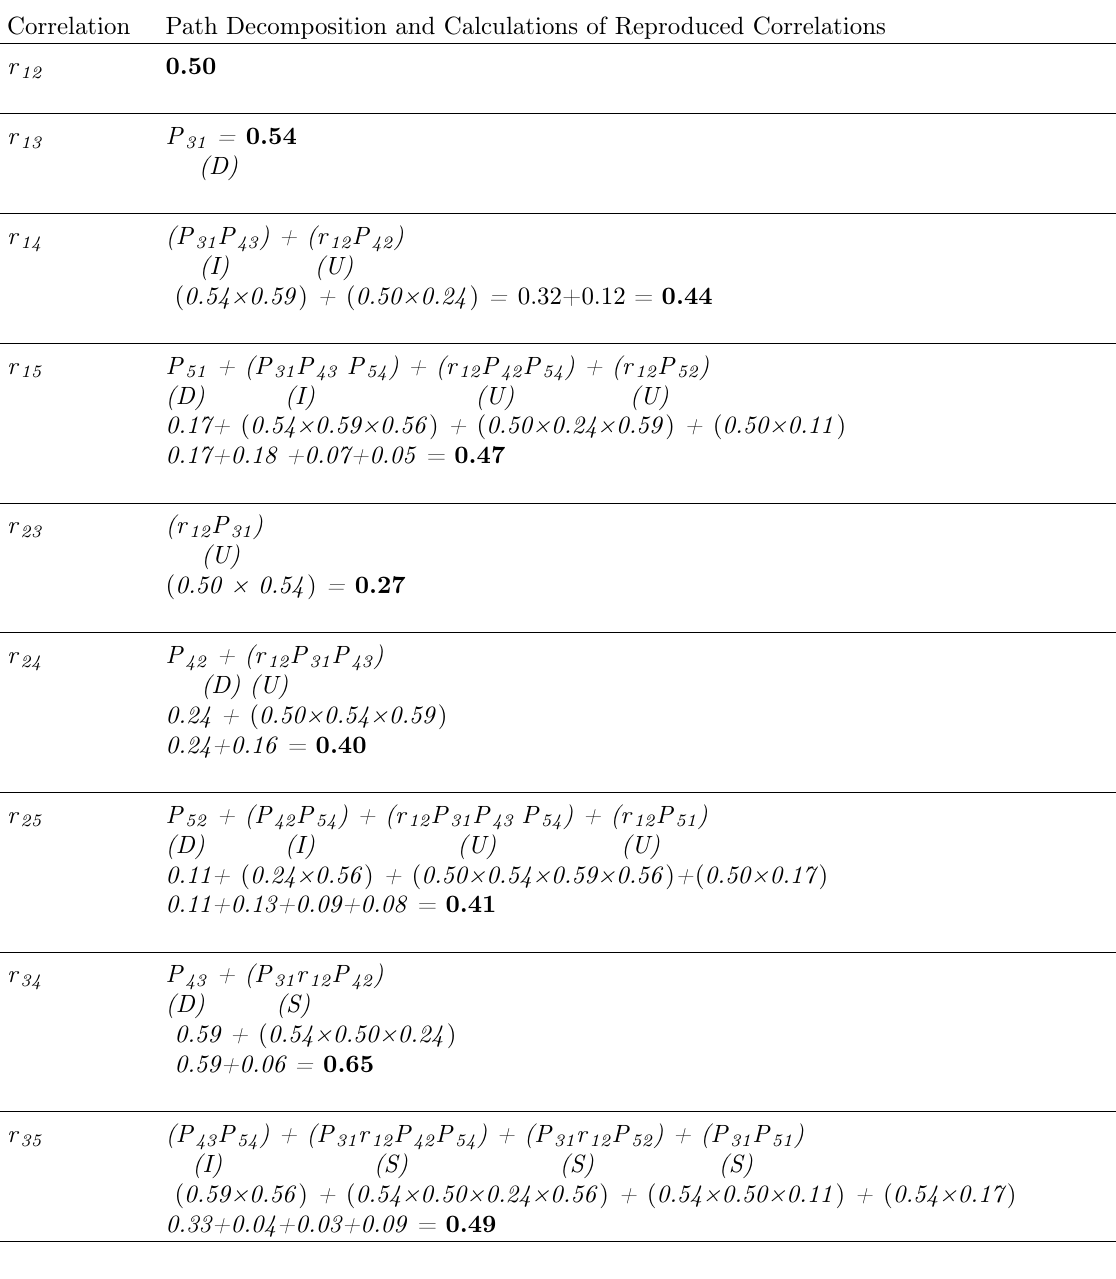
Table 5. Path Decompositions and Calculation of Reproduced Correlations for the Endogenous and Exogenous Factors in the Hypothesized Model in Figure 2. Reproduced Correlation Path Decomposition and Calculations of Reproduced